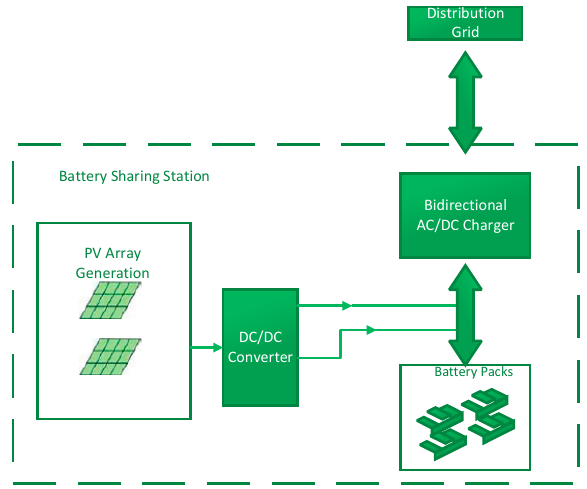
Figure 12. Battery sharing station (BShS) with a local renewable energy source (RES) connected bidirectionally to the grid.